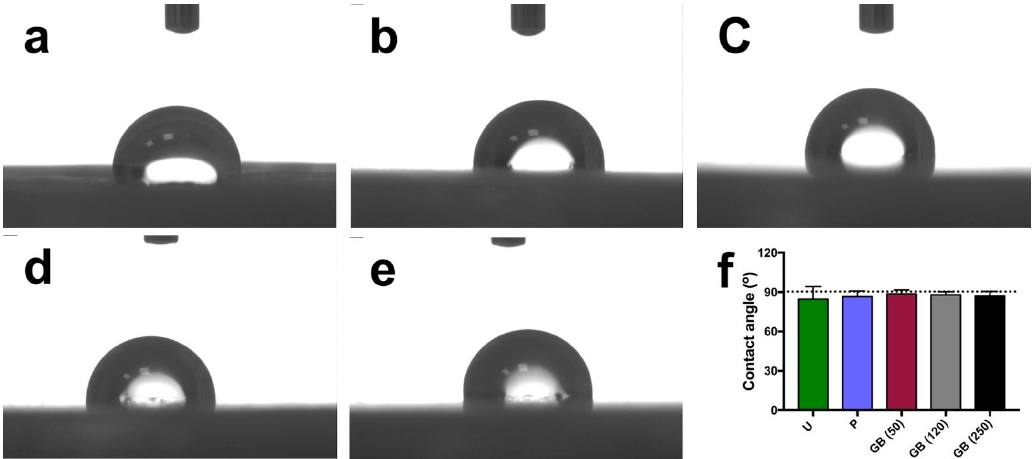
Figure 3. Contact angle measurements of different FFF 3D printed PEEK samples. ( a ) untreated; ( b ) polished; ( c ) grit-blasted (50 µm); ( d ) grit-blasted (120 µm); ( e ) grit-blasted (250 µm); ( f ) quantitative contact angle values (means ± standard deviations). The dotted line indicates a contact angle of 90°, the borderline between hydrophilicity and hydrophobicity. U: untreated group; P: polished group; GB (50): grit-blasted group with 50 µm Al 2 O 3 particles; GB (120): grit-blasted group with 120 µm Al 2 O 3 particles; GB (250): grit-blasted group with 250 µm Al 2 O 3 particles.